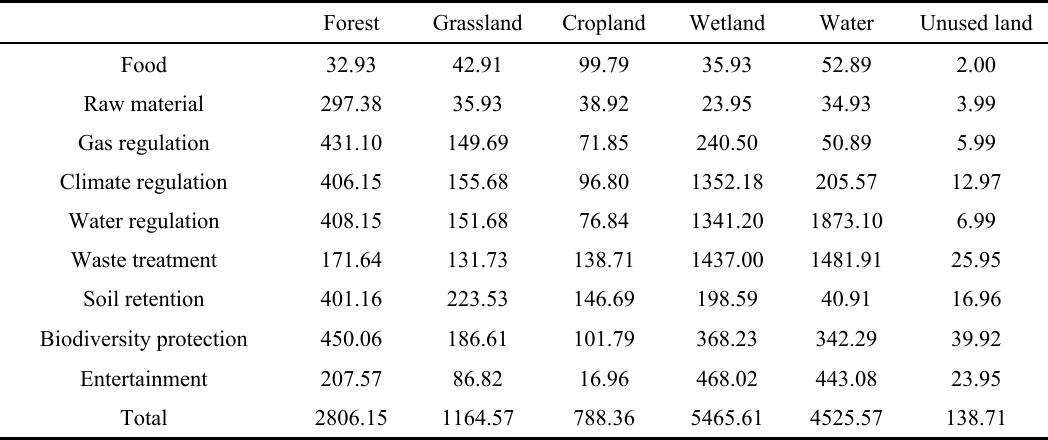
Table 3. The coefficients of ESV to each land cover types per unit area ($ · ha -1